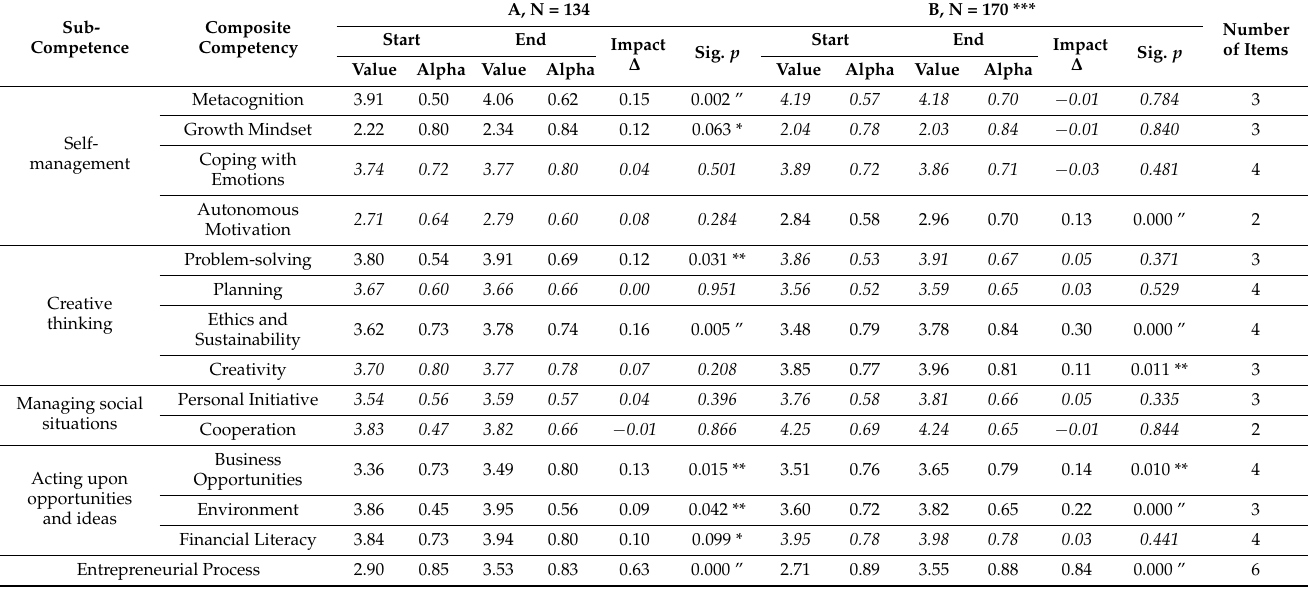
Table A1. Entrepreneurship sub-competences and composite competencies assessed by students at the start and end of the course, universities A and